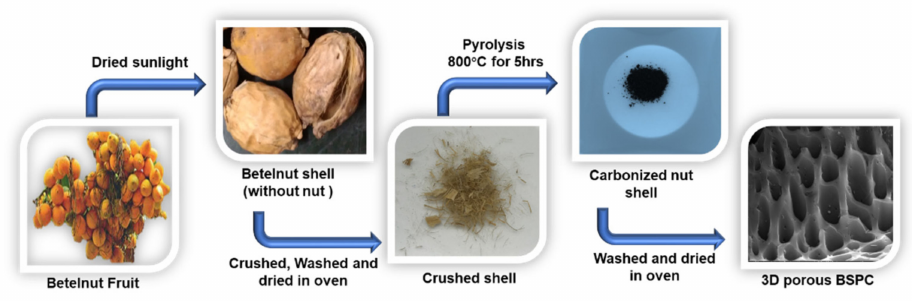
Figure 1. Schematic representation of the preparation of 3D hierarchical porous